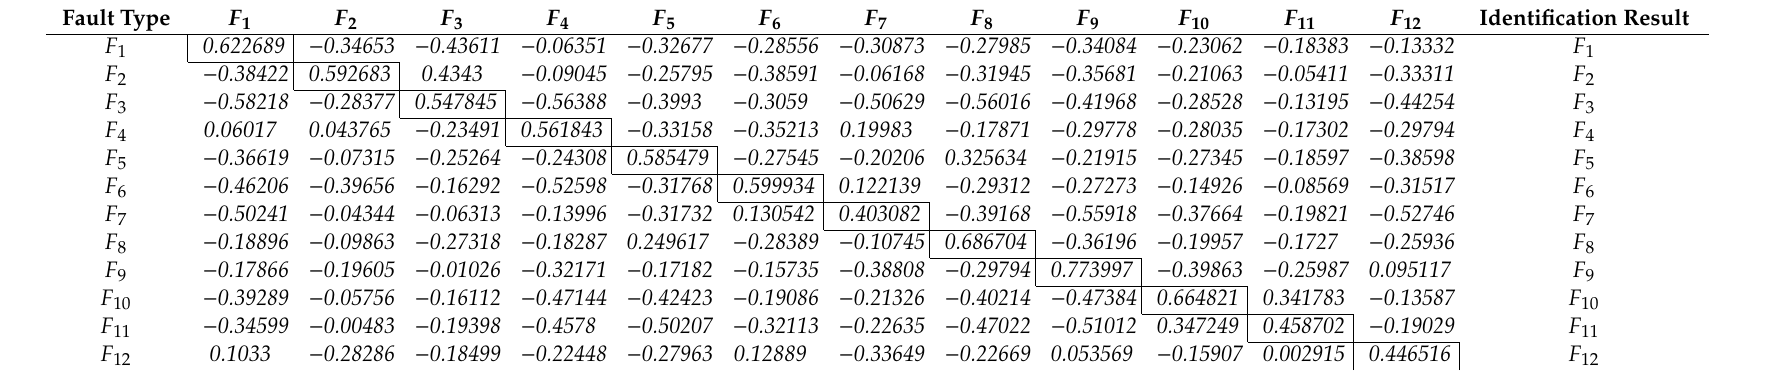
Table 5. Results for the identification of di ff erent switch faults in an inverter working at 80